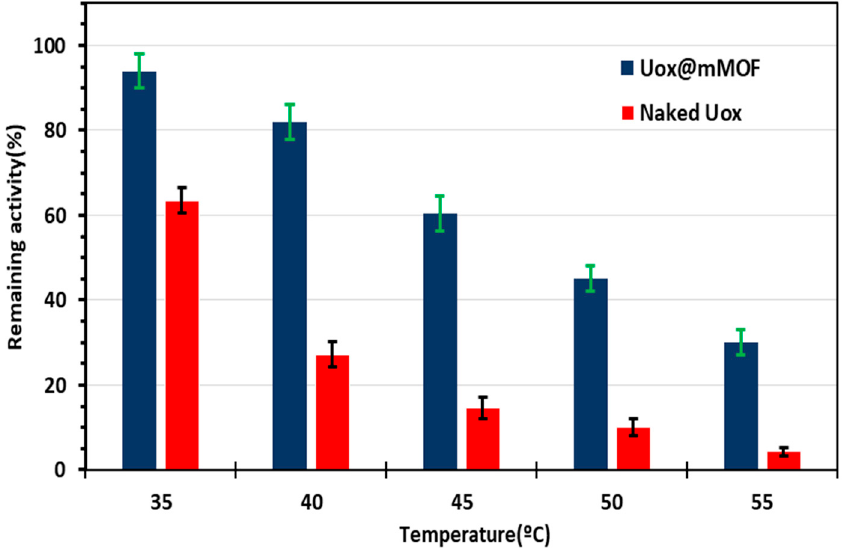
Figure 7. The remaining activity of Uox and Uox@NimMOF after heat treatment. Thermal inactiva- tion of Uox and Uox@NimMOF at 45, 50, and 55 °C (for 5 min) is shown. Please note that the activity of Uox and Uox@NimMOF before the heat treatment was considered to be 100%.